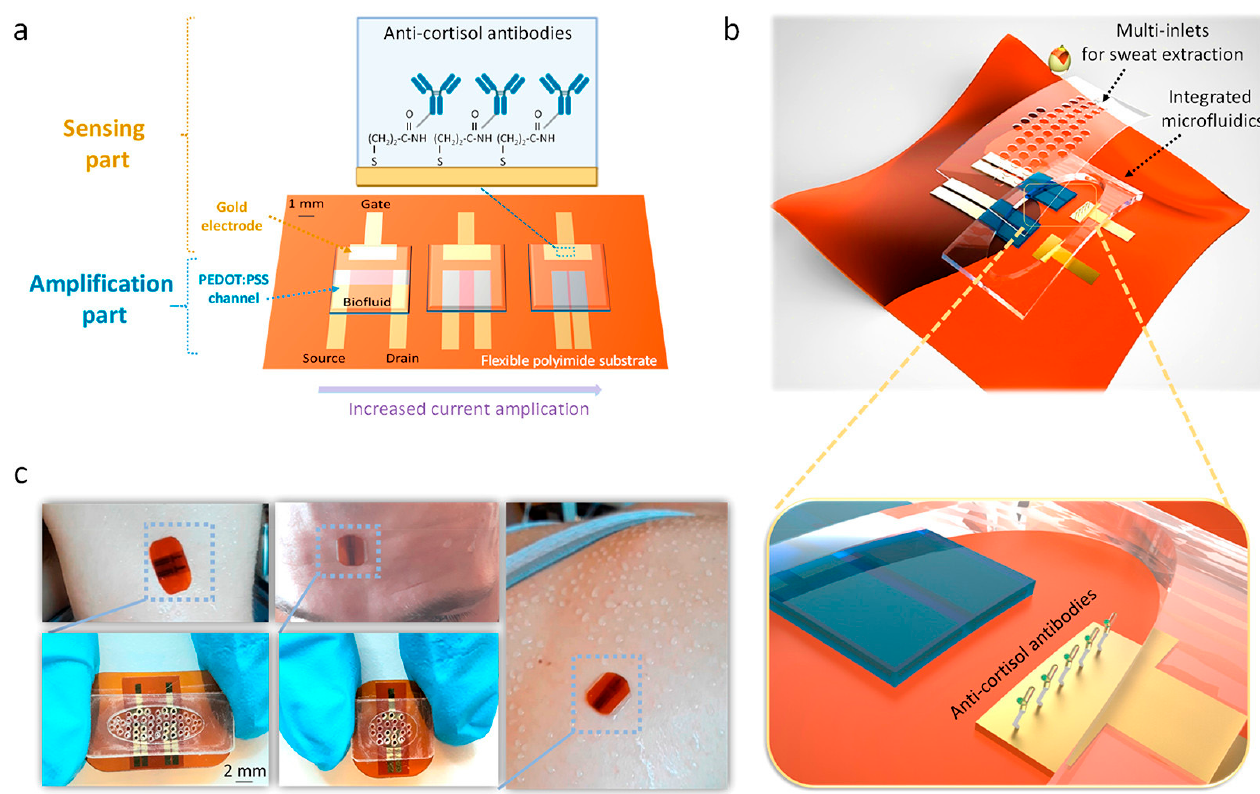
Figure 9. Organic transistor structure and sticker application. ( a ) Schematic of the biosensing principle involved and structure of the OECT devices, including antibody-coated gate electrodes and the organic PEDOT:PSS channel for current amplification; the latter shows three OECT devices with different PEDOT:PSS channels of an increased width per length ratio. ( b ) 3D-image with two OECTs integrated into a microfluidic system for direct sweat collection and zoom of the gate electrode with the anticortisol antibody immobilized. ( c ) Application of a cortisol sensing sticker on the human skin for sweat collection during sports activities; the microfluidic part with the multiple inlets is placed in contact with the skin. Reprinted with permission Ref. [96]. Copyright (2022), American Chemical Society.